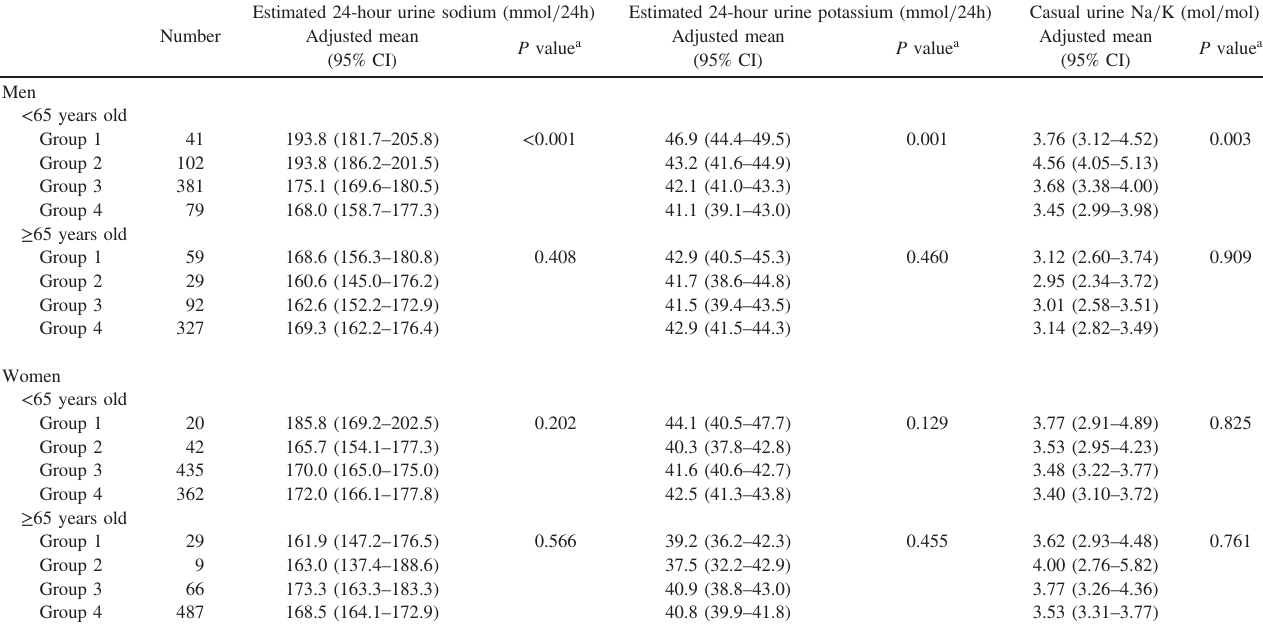
Table 4. Multivariable-adjusted means of estimated 24-hour urine sodium and potassium and casual urine Na / K according to occupation groups by sex and age: NIPPON